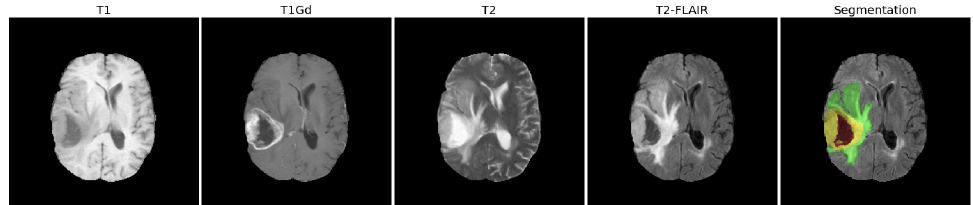
Figure 2. The four MRI sequences (T1, T1Gd, T2, T2-FLAIR) and the corresponding segmentation mask of an example patient “TCGA-02-0047”. The whole tumor (WT) consists of the necrotic part (NCR, red color), the enhancing tumor part (ET, yellow color), and the peritumoral edematous tissue (ED, green color). The tumor core (TC) consists of the necrotic part (NCR, red color) and the enhancing part (ET, yellow